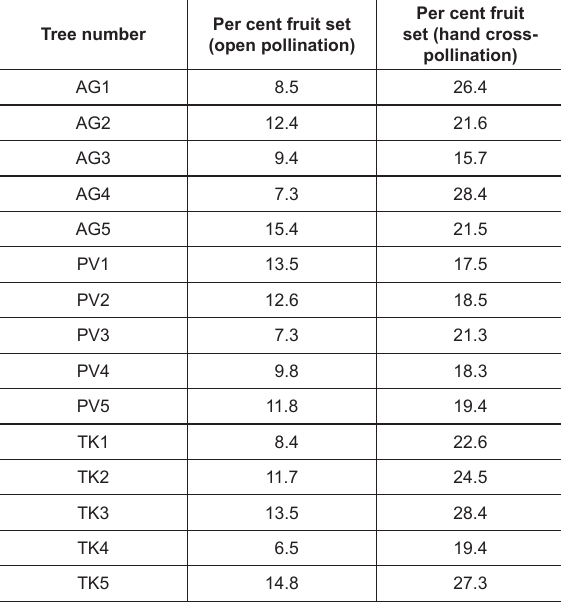
Table 2. Fruit set under open pollinations and manual xenogamous cross-pollinations in Shorea roxburghii at three sites in the Tirumala Hills Tree